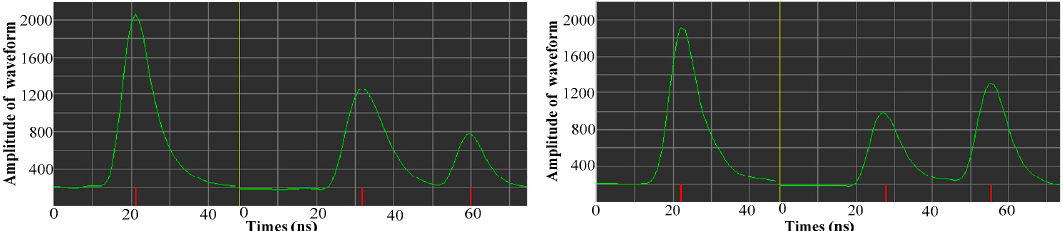
Figure 2. Two typical waveform datasets of light detection and ranging (LiDAR). The horizontal scale is the time in nanoseconds, and the vertical scale is the relative amplitude of the waveform. the vertical yellow line is the start of each return waveform section. The vertical red line is the location of each return pulse.